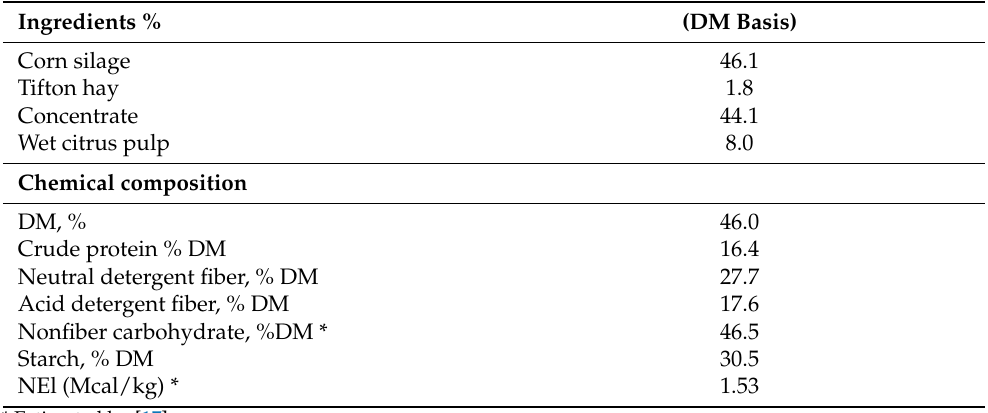
Table 1. Ingredients and chemical composition of the total mixed